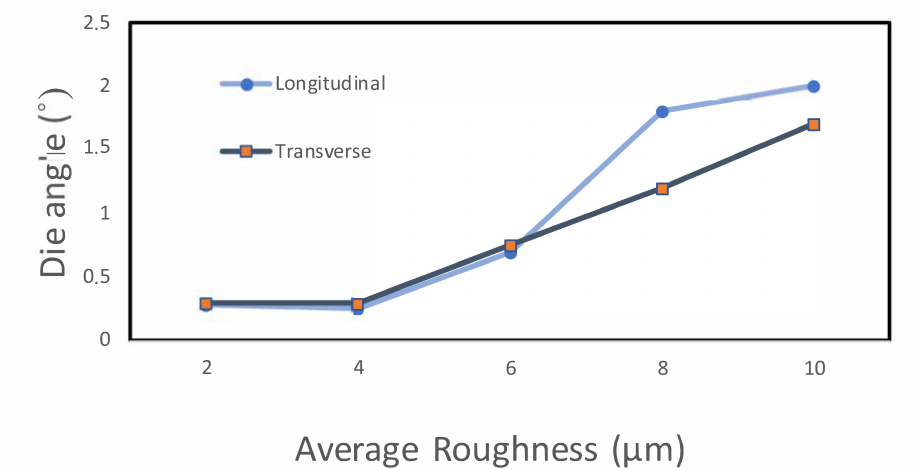
Figure 13. Die angle vs. roughness measured in both